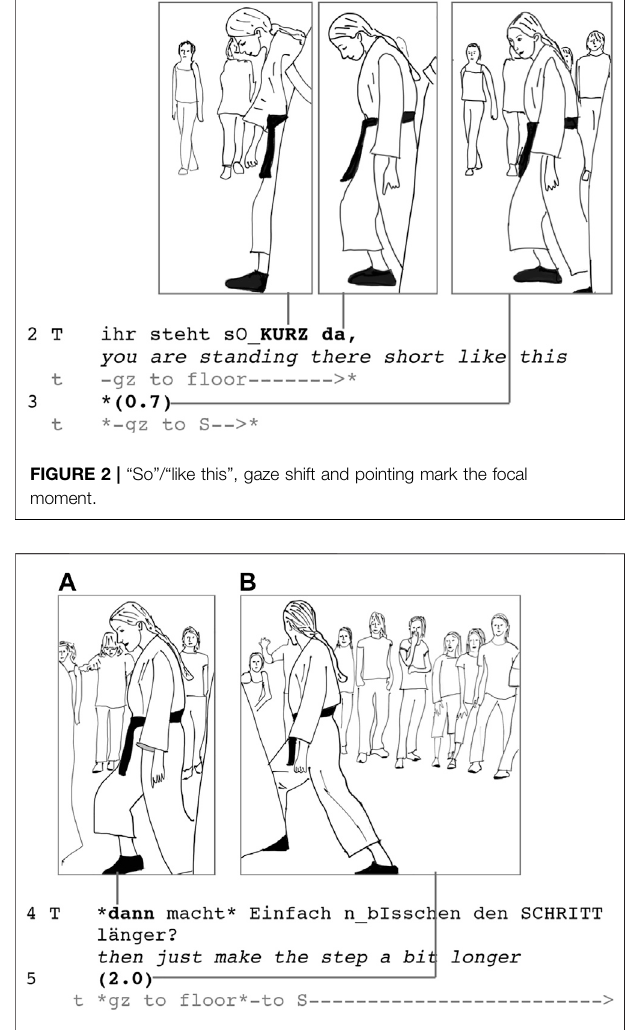
FIGURE 3 | Gaze shift to fl oor and back to